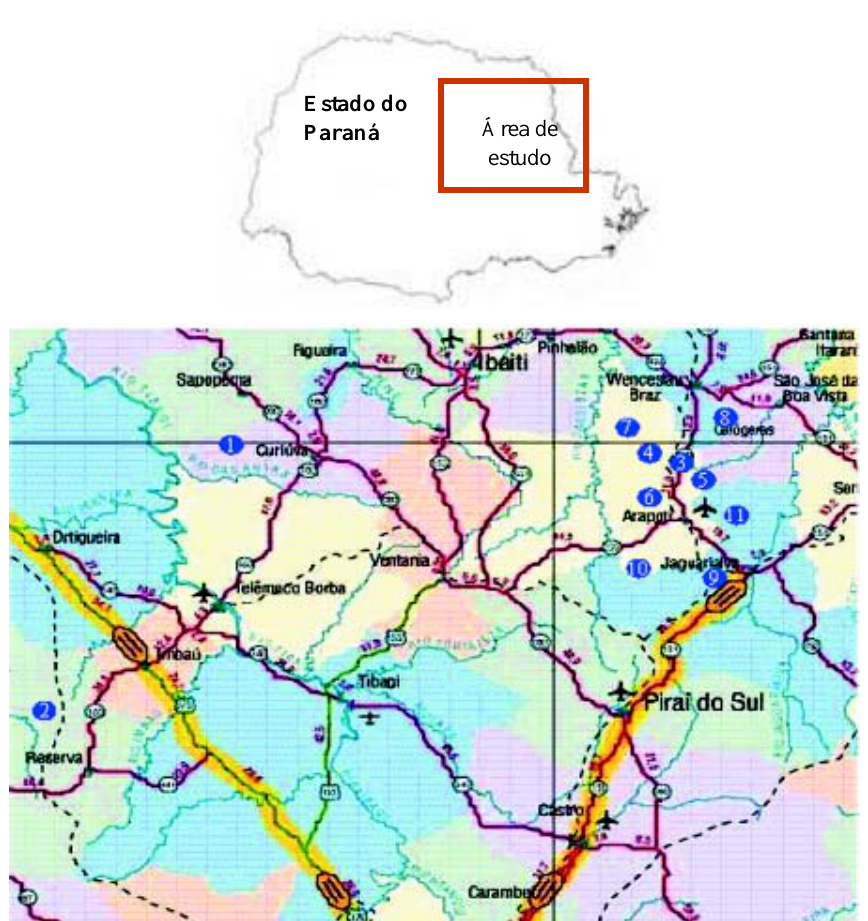
Figura 1. Locais de coleta das amostras, em diferentes localizações próximas ao município de Arapoti, Paraná. A numeração indica locais de coleta de amostra de